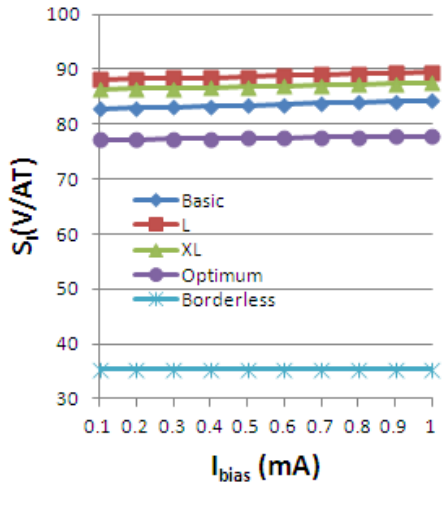
Figure 20. Current-related sensitivity of the simulated Hall Effect